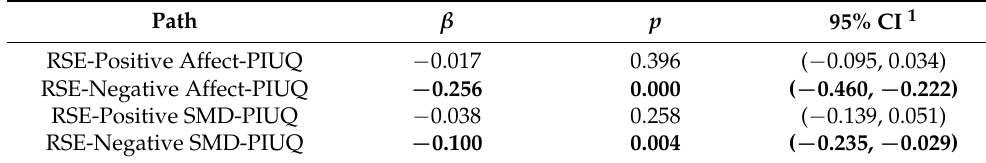
Table 4. Standardised results of mediation